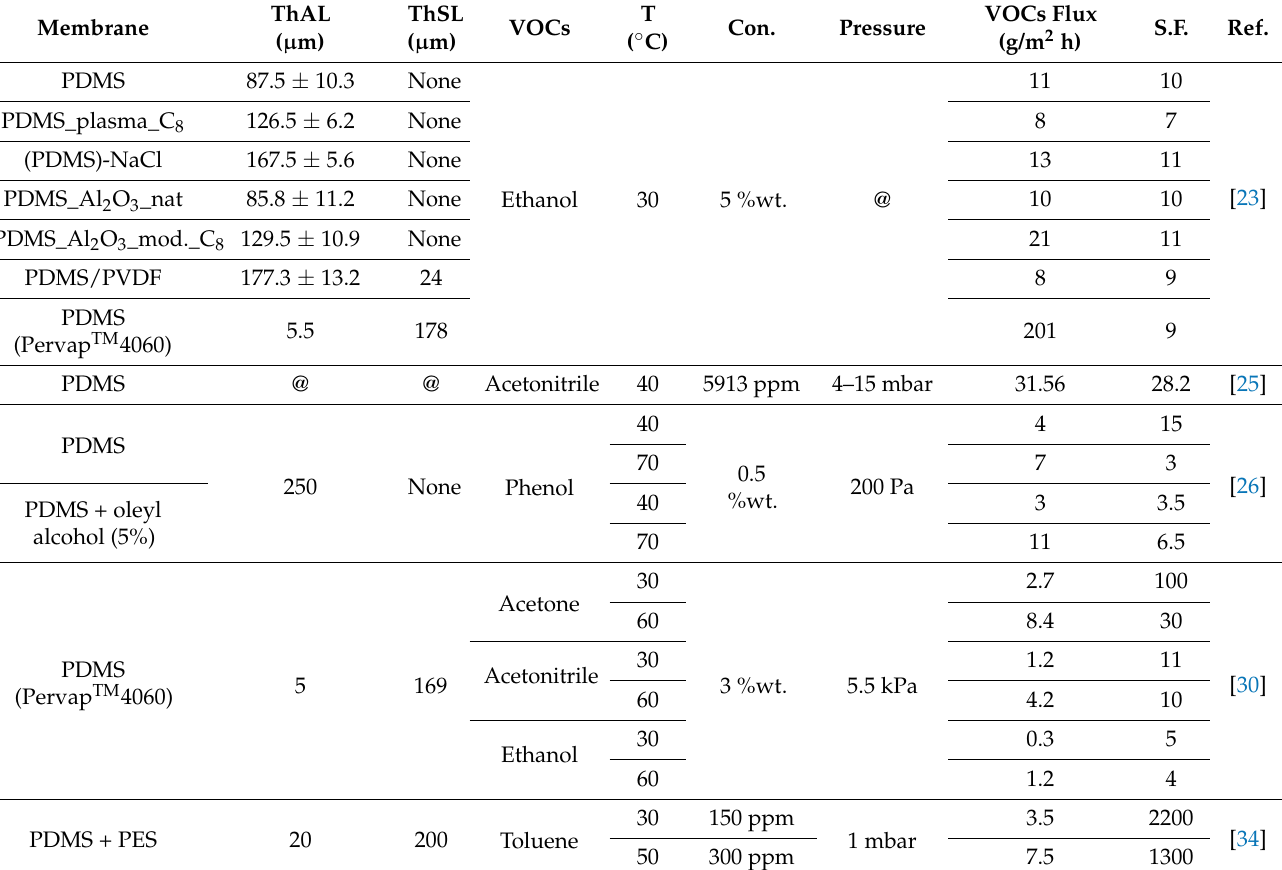
Table 1. The performance of previous PV processes using PDMS membranes for the recovery of various VOCs from aqueous